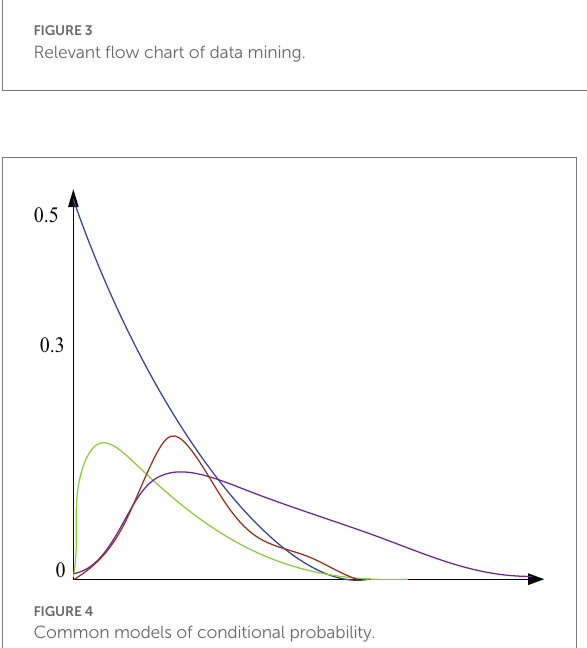
FIGURE 4 Common models of conditional